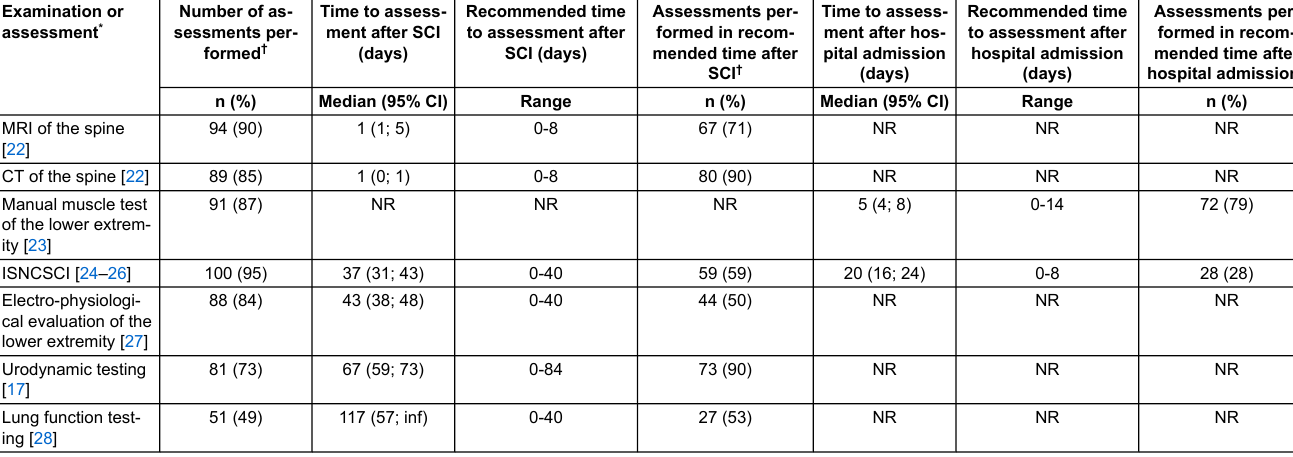
Table 3: Time to examination and assessment after hospital admission and spinal cord